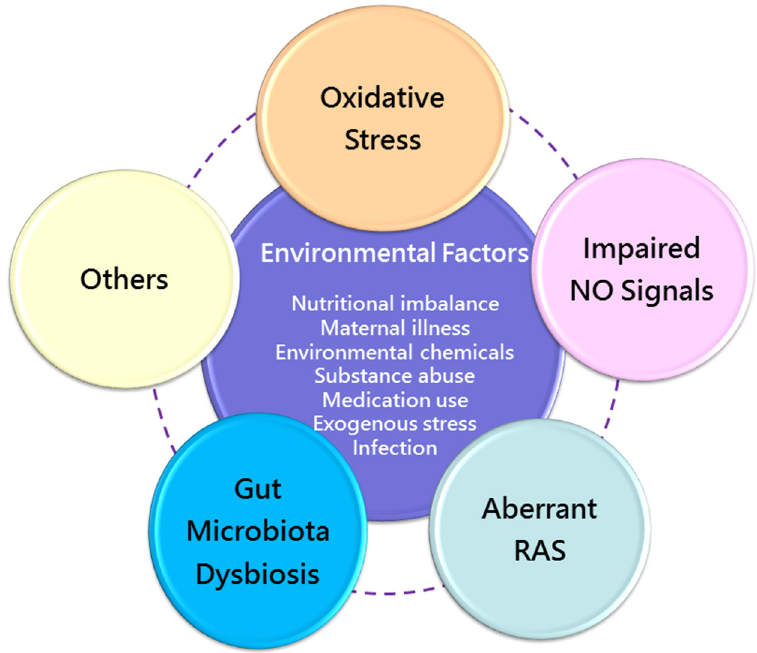
Figure 3. Overview of the common mechanisms of renal programming in response to various environmental risk factors during the first 1000 days of life. NO = nitric oxide; RAS = renin–angiotensin system.